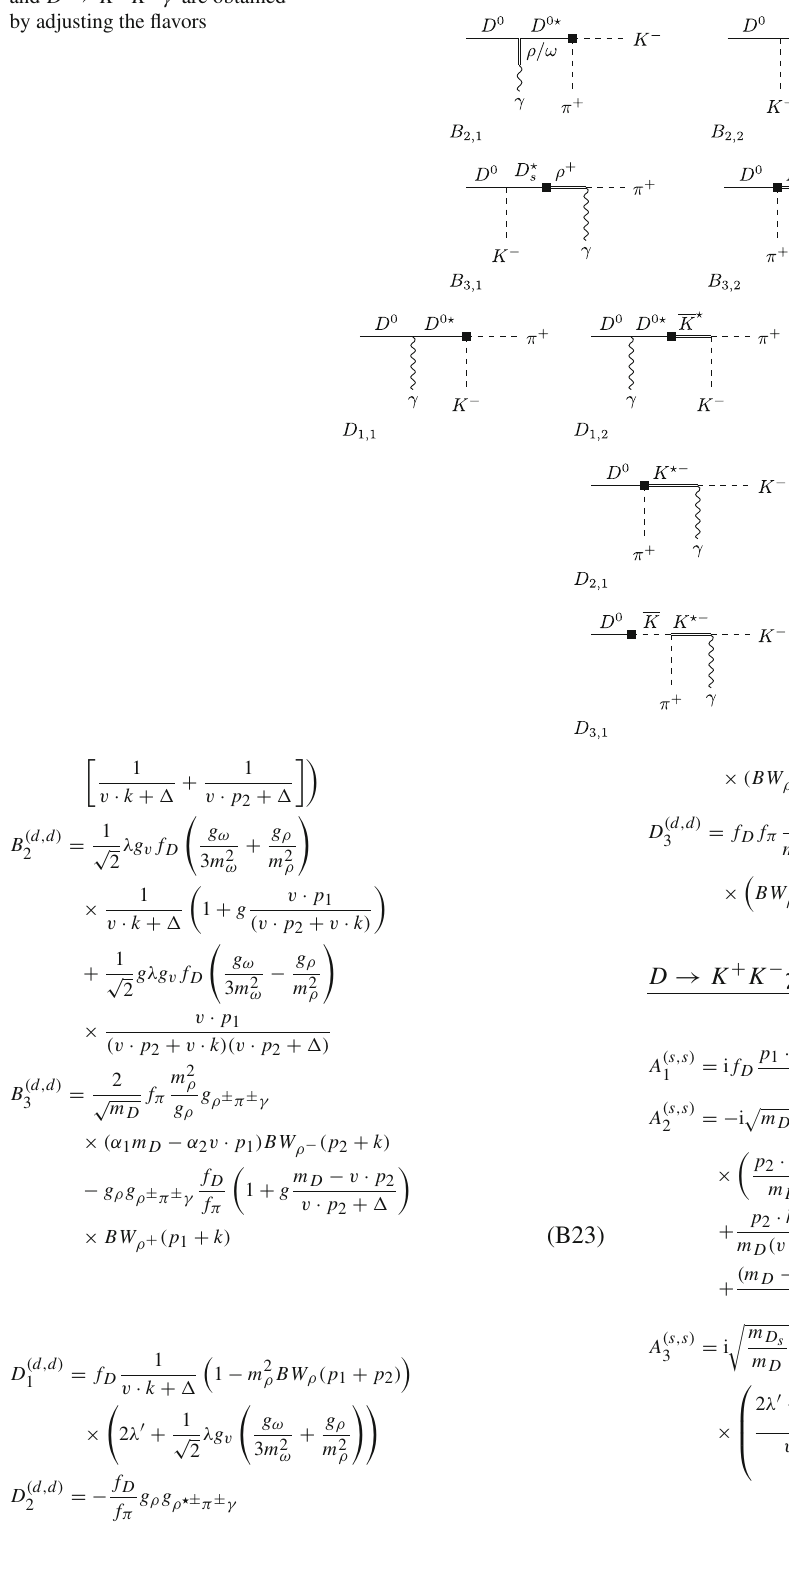
Fig. 19 Feynman diagrams for the D → π + K − γ decay, which contribute to the parity-odd form factors B and D . The diagrams for the decays D → π + π − γ and D → K + K − γ are obtained by adjusting the